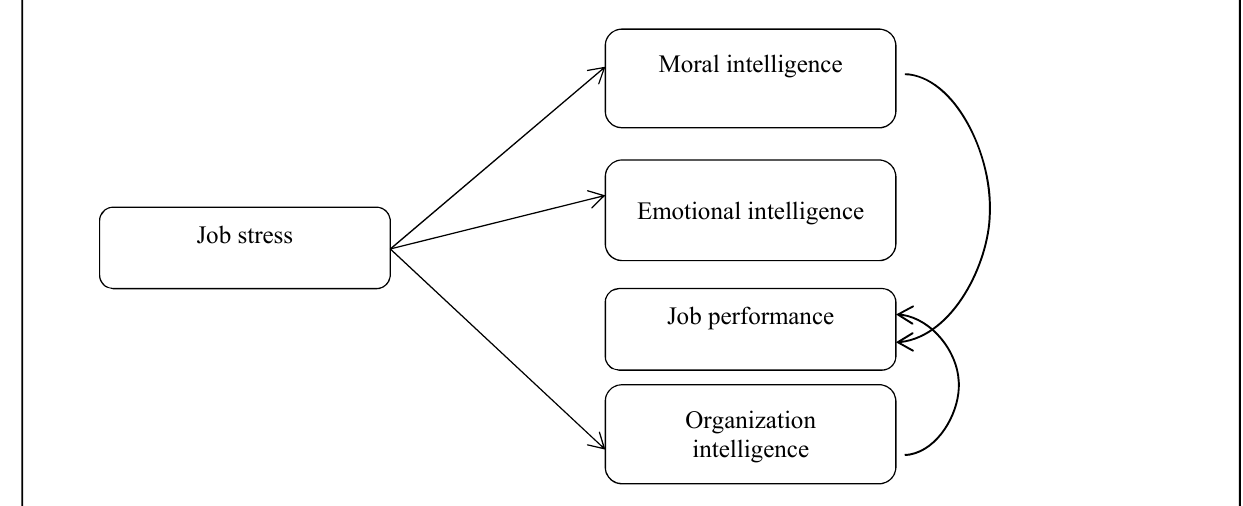
Fig. 2. The results of the